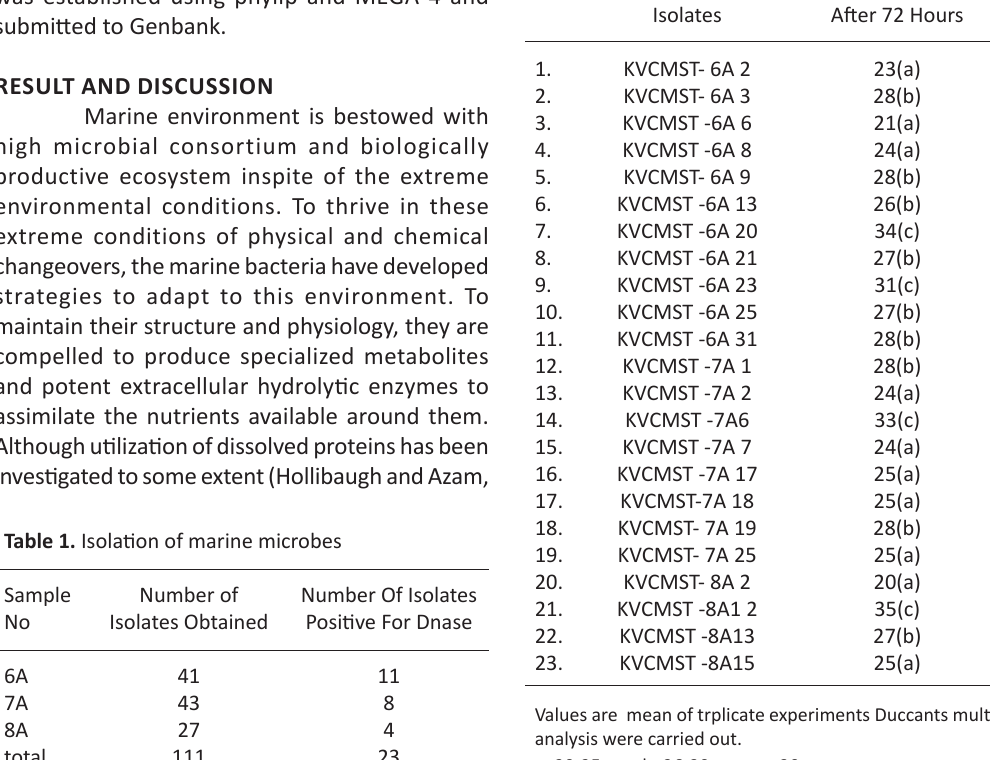
Table 2. Screening and isolation of extracellular DNase activity by different isolates